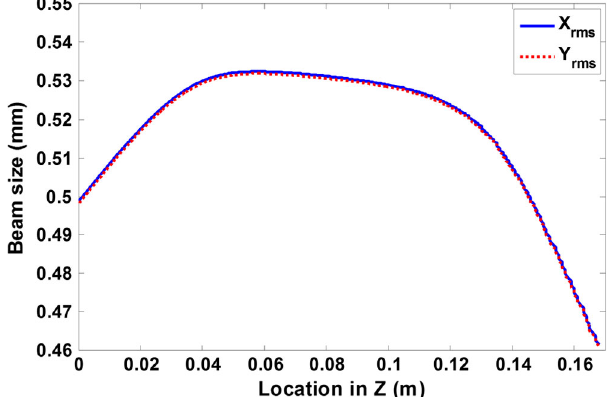
FIG. 10. The change in the ion beam size during propagation to the MCP under an external